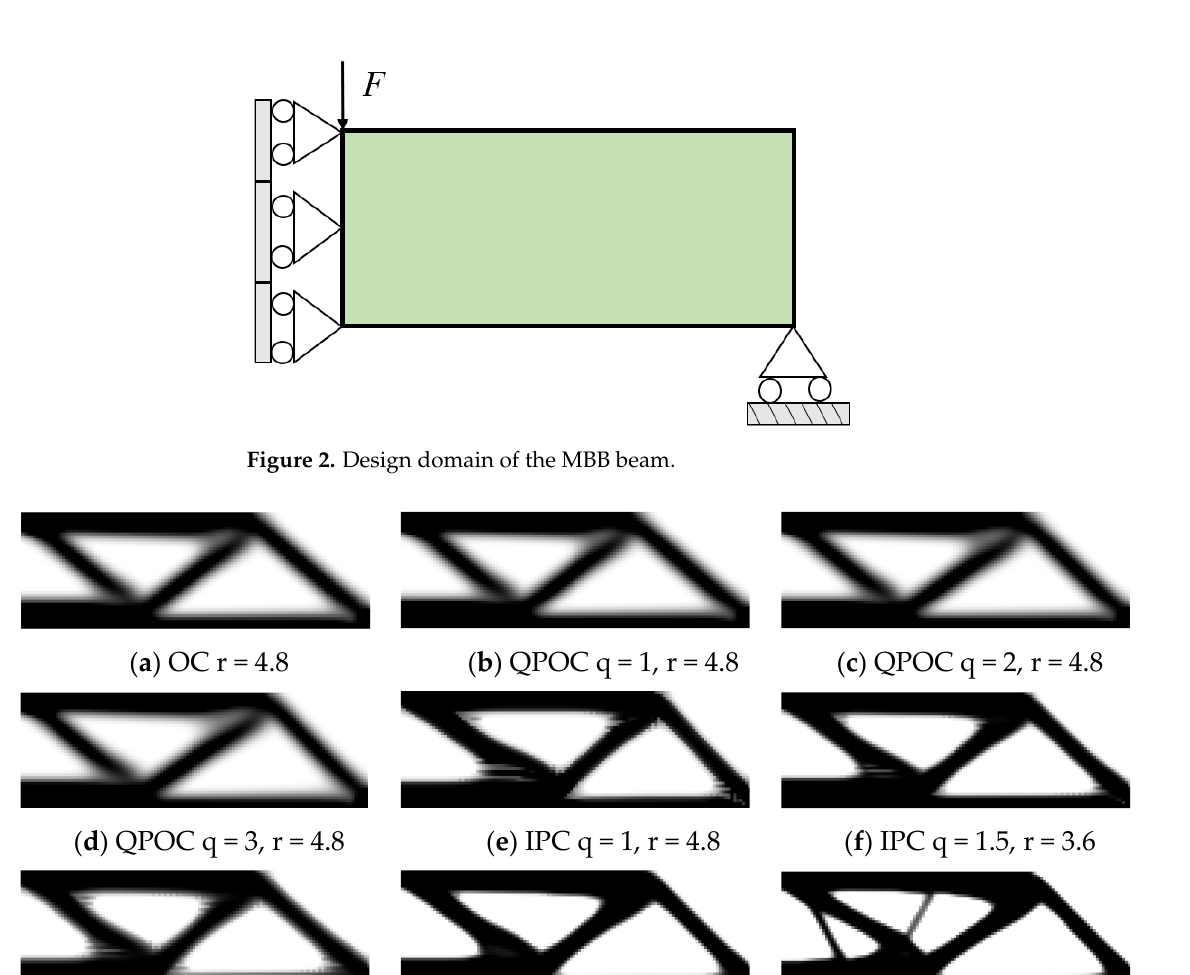
Figure 3. Optimized designs of the MBB beam with different methods and parameters.